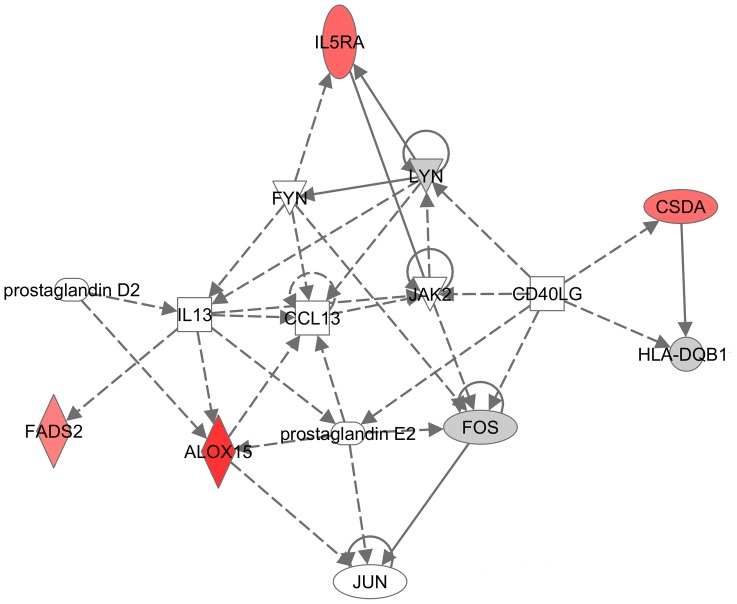
Gene network.Ingenuity Pathway Analysis network of differentially expressed genes at post-challenge comparing ERs and DRs. Dash lines indicate indirect relationships, whereas solid lines indicate direct relationships. The red colour indicates significant genes at an FDR of 10%. The grey colour indicates non-significant genes at an FDR of 10%.